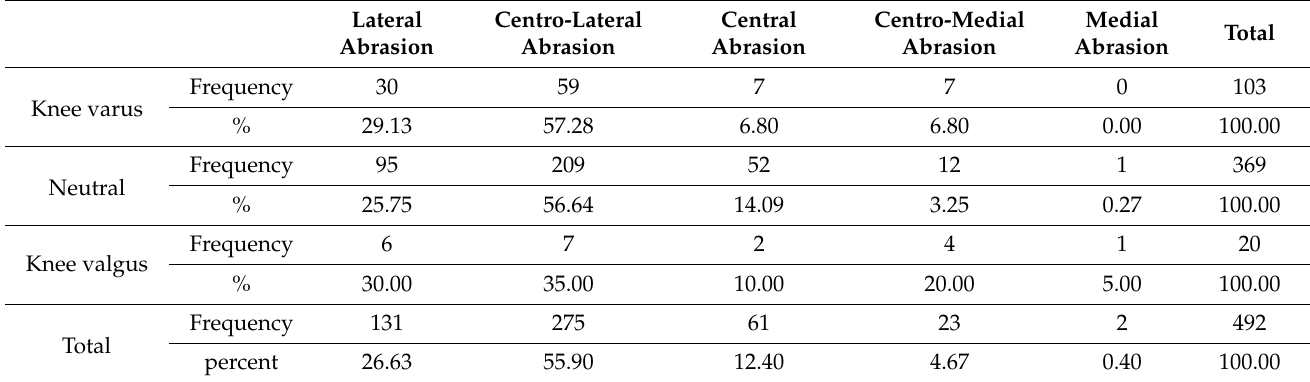
Table 8. Relationship between the knee varus/valgus and shoe abrasion (X 2 = 29.23, df = 8, p = 0.00).